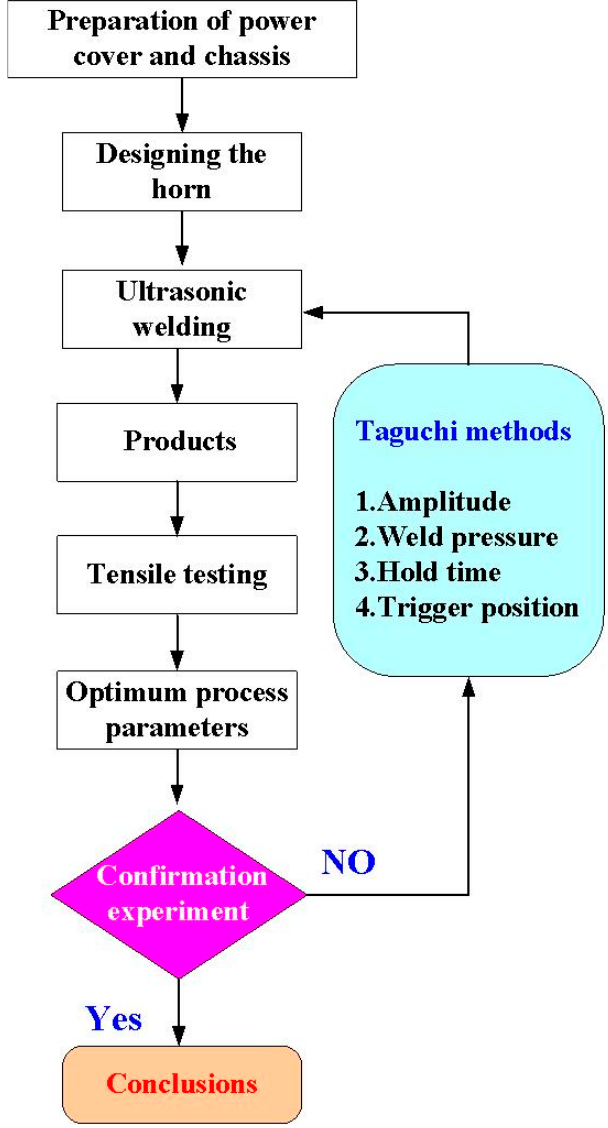
Figure 1. Flow diagram of the experimental methodology. Both the cover and chassis of a 3C power case were fabricated by plastic injection molding via polycarbonate (PC) [24] using a plastic injection molding machine (KT2S, Kinki Inc., Taipei city, Taiwan) [25]. The process parameters involve injection pressure of 18 MPa, injection speed of 80 mm/s, and cooling time of 10 s. The length, width, and height of the cover are 42.8 mm, 26 mm, and 51.8 mm, respectively. The length, width, and height of